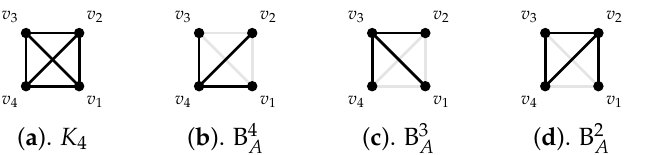
Figure 3. The complete graph K 4 and its three possible basis graphs with support A = { 1,2,3,4 }